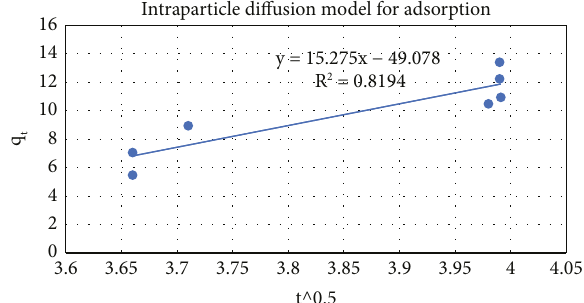
y = 15.275x − 49.078 R 2 = 0.8194